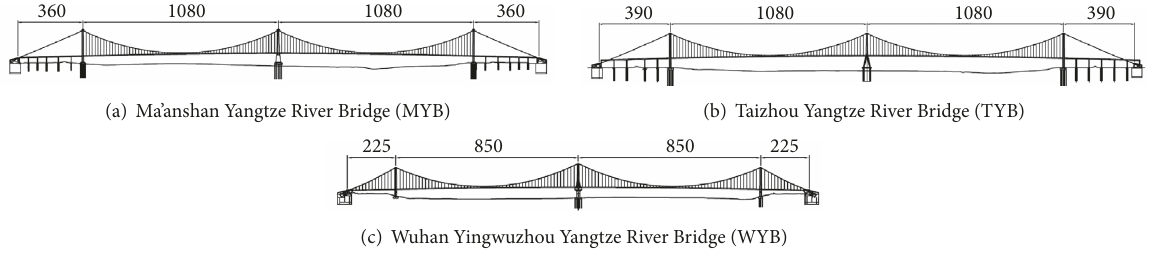
Figure 1: The configuration of three suspension bridges.